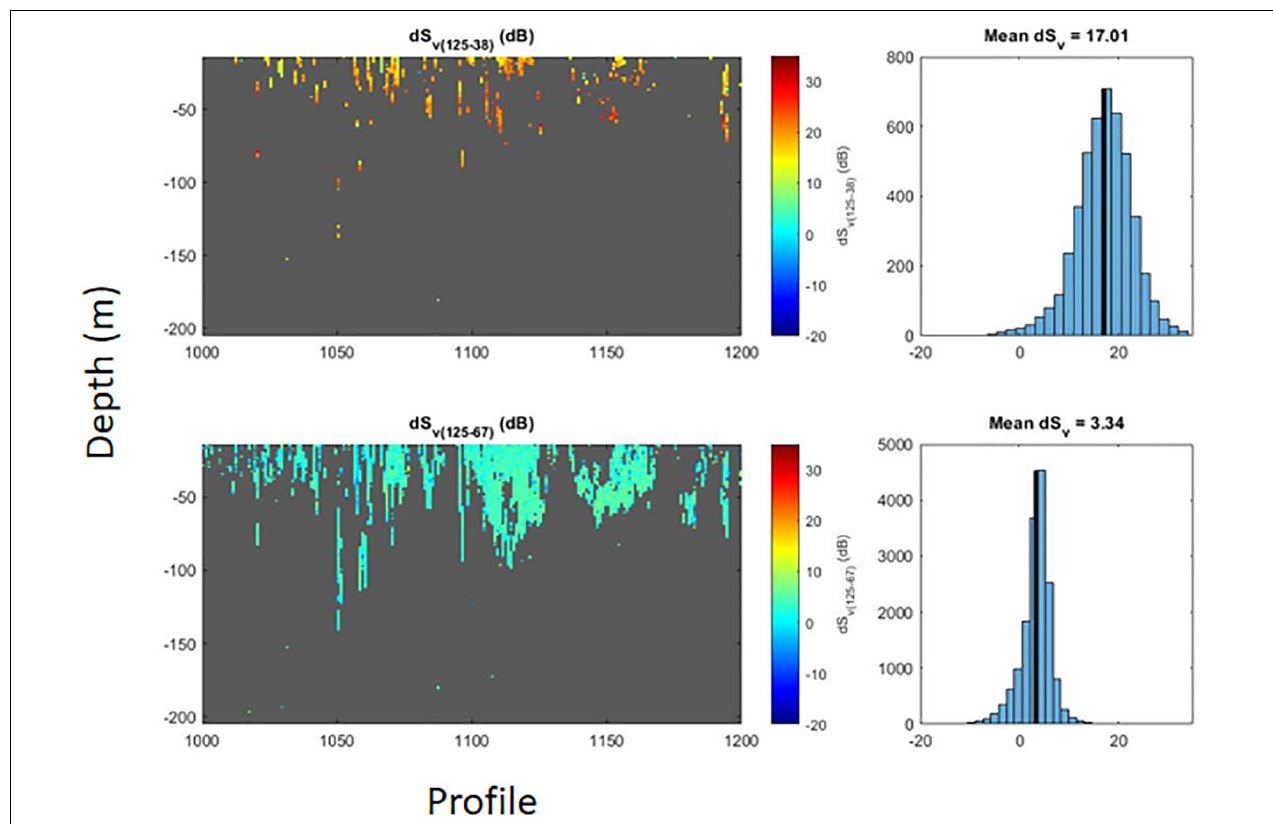
FIGURE 6 | Decibel (dB) differences between acoustic returns collected by AMLR02 during austral summer 2018/19. The upper left panel shows differences in volume backscattering strength (dSv) for, approximately, the standard two-frequency algorithm for identifying krill targets (125 kHz minus 38 kHz). The upper right panel shows the histogram of the dB differences (blue bars) and mean dB difference (black reference line) for this algorithm. The lower left panel shows differences in volume backscattering strength for a krill-identification algorithm using differences between returns at 125 and 67.5 kHz, and the lower right panel shows the distribution of dB differences (blue bars) and mean dB difference (black reference line) for this alternative target-identification